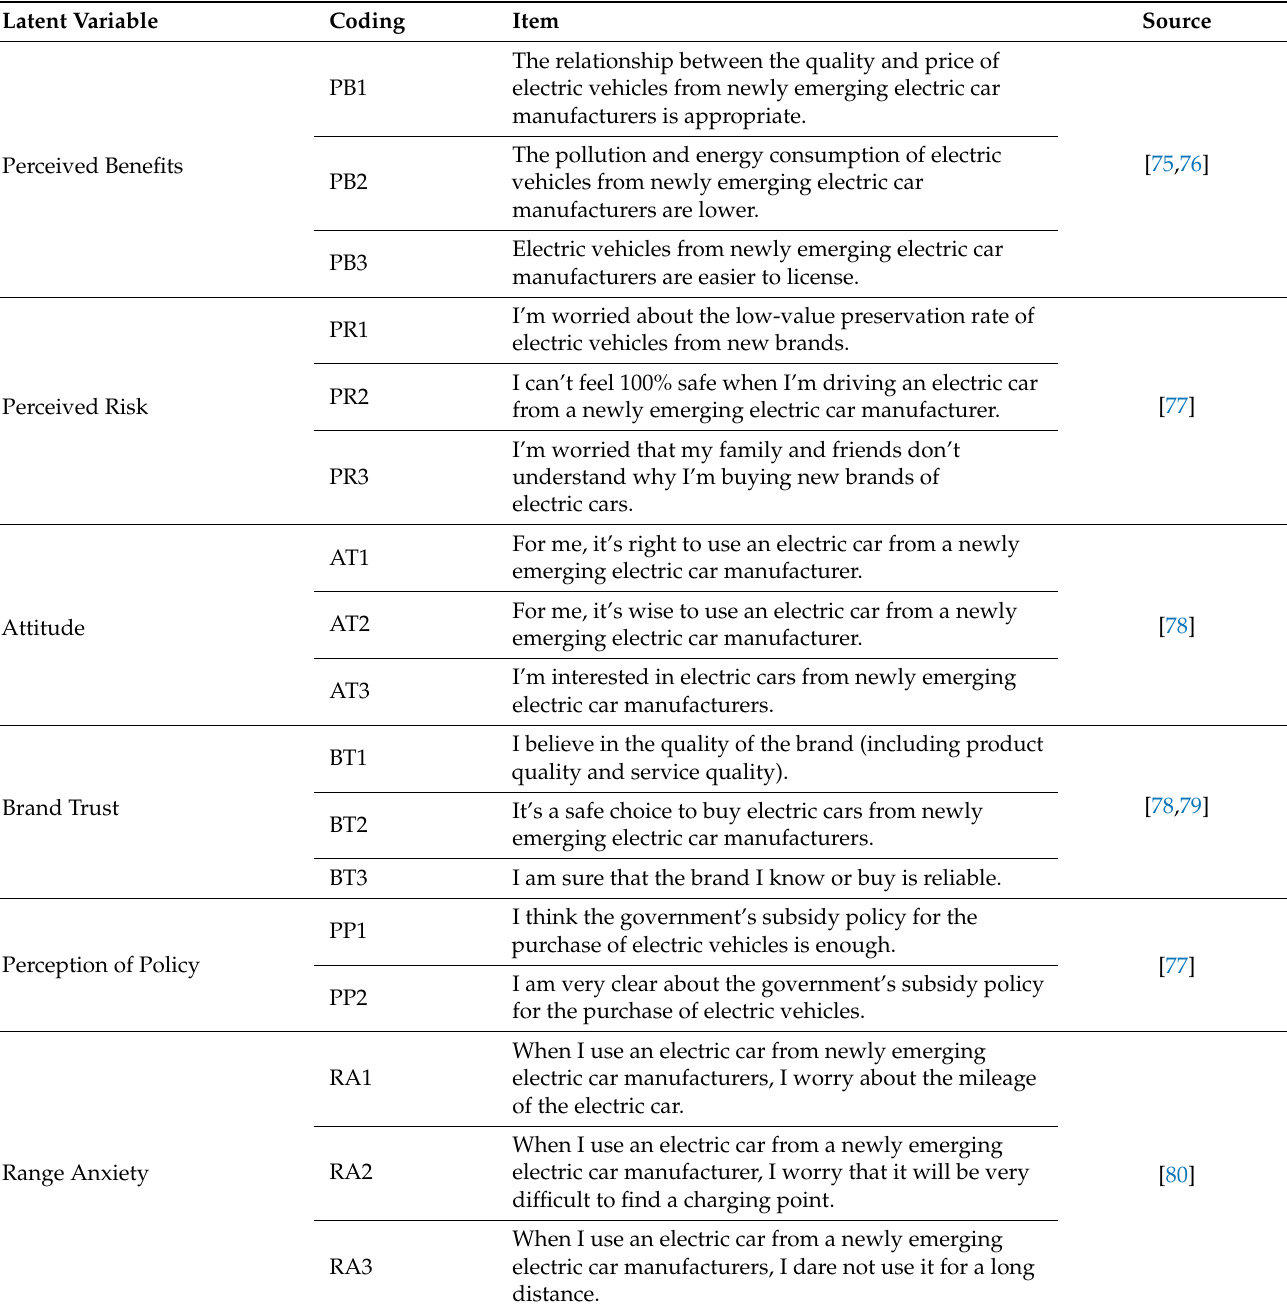
Table 2. Questionnaire design and literature